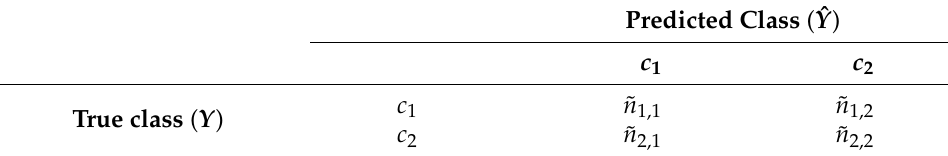
Table 2. A median confusion matrix for two true classes Y ∈ { c 1 , c 2 } (in rows) and two predicted classes ˆ Y ∈ { c 1 , c 2 } (in columns). Assuming that value 1 n i , j comes from the 1-st iteration, value 2 n i , j comes from the 2-nd iteration, ..., value f n i , j comes from the f -th iteration, then ˜ n i , j is median over values { 1 n i , j , 2 n i , j , . . . , f n i , j }